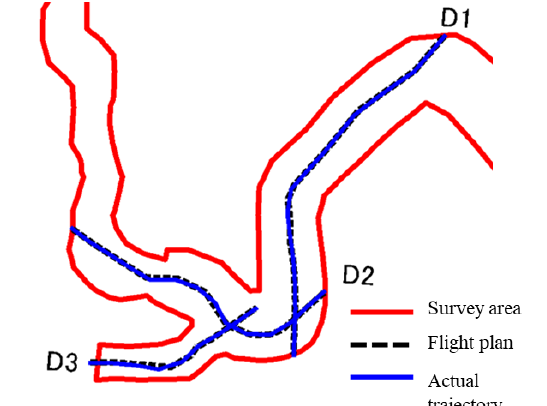
Figure 11. Deviation of actual trajectory from the flight plan of